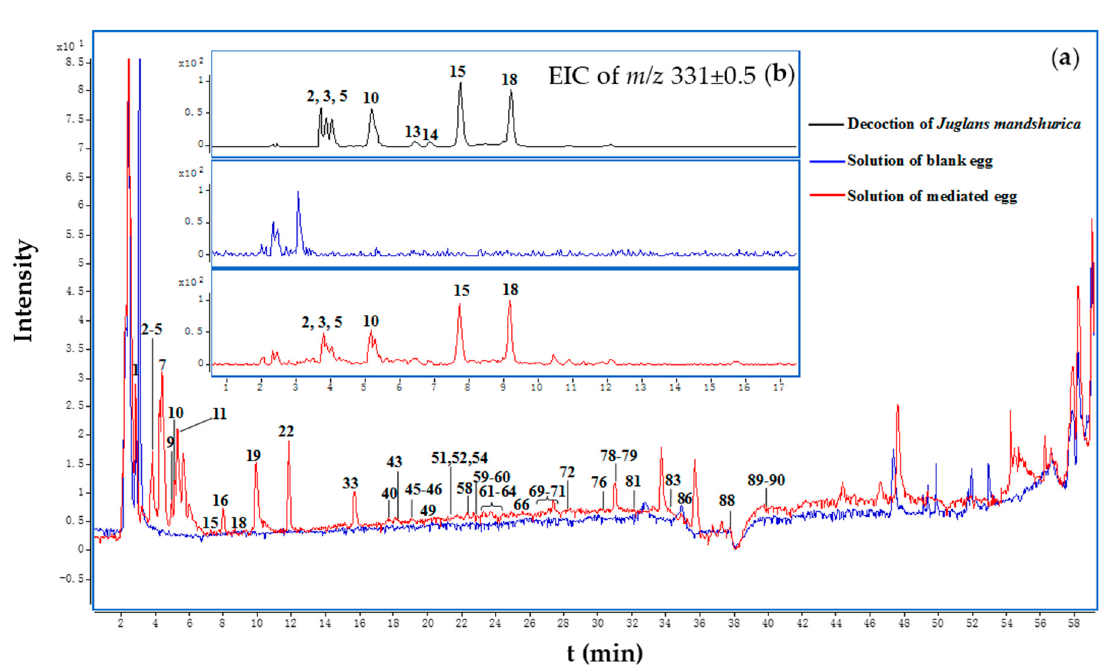
Figure 2. ( a ) Total ion chromatograms (TIC) in negative-ion mode (from HPLC-ESI-Q-TOF-MS) of medicated and blank egg solutions and ( b ) extracted ion chromatograms (EIC) of the Juglans mandshurica decoction and blank and medicated egg solutions at m / z 331 ± 0.5 in MS. The peak numbering in TIC and EIC relates to the numbered compounds listed in Table 1.